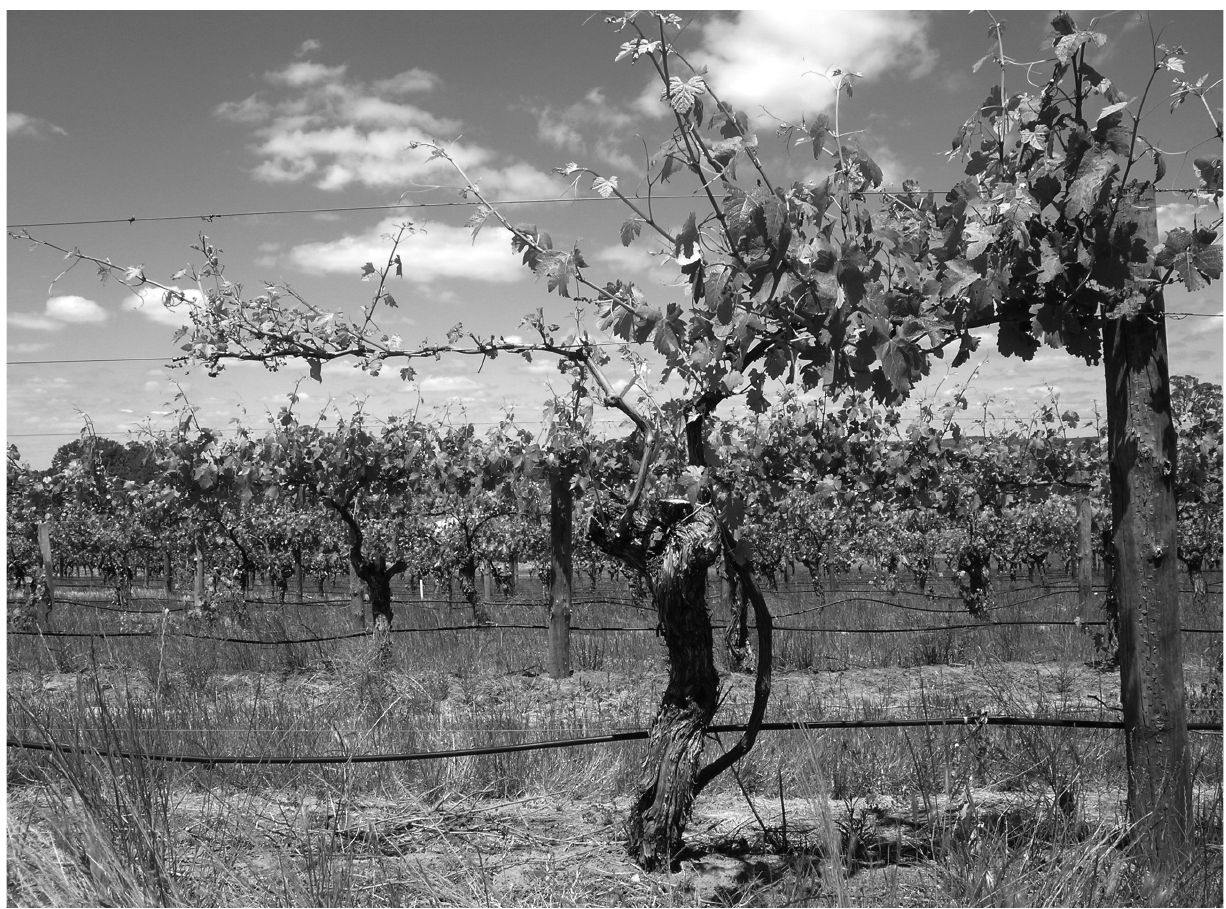
Figure 3. ‘Shiraz’ vine in Trial 6 with shoots exhibiting Eutypa dieback symptoms on the left cordon that emerged from high on the trunk, presumably from infected wood, and healthy shoots on the right cordon that emerged from the bottom of the trunk, presumably from uninfected